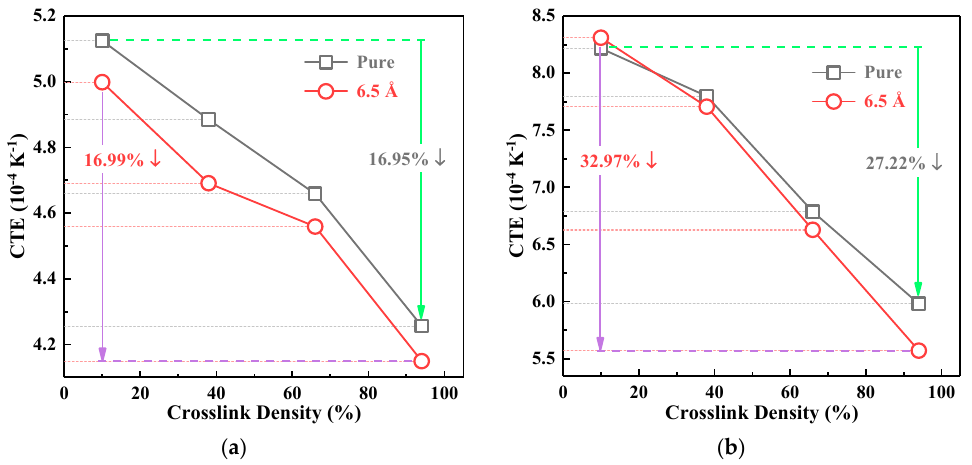
Figure 8. The Coefficient of Thermal Expansion (CTE) in the glassy state and rubbery state. ( a ) Glassy state; ( b ) rubbery state.